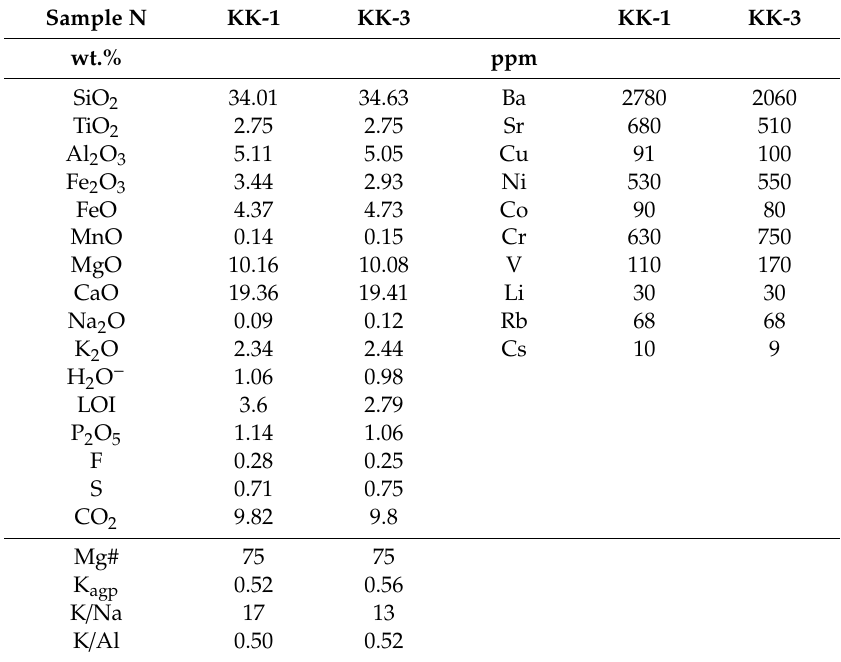
Table 6. Representative major and minor element analyses of the Vinoren aillikite.